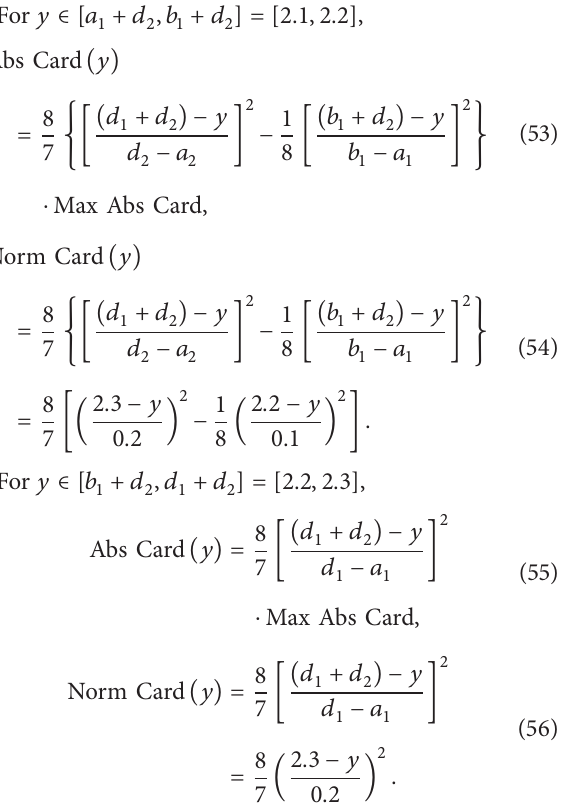
For 𝑦 ∈ [𝑎 1 + 𝑑 2 , 𝑏 1 + 𝑑 2 ] = [ 2 . 1 , 2 . 2 ] ,